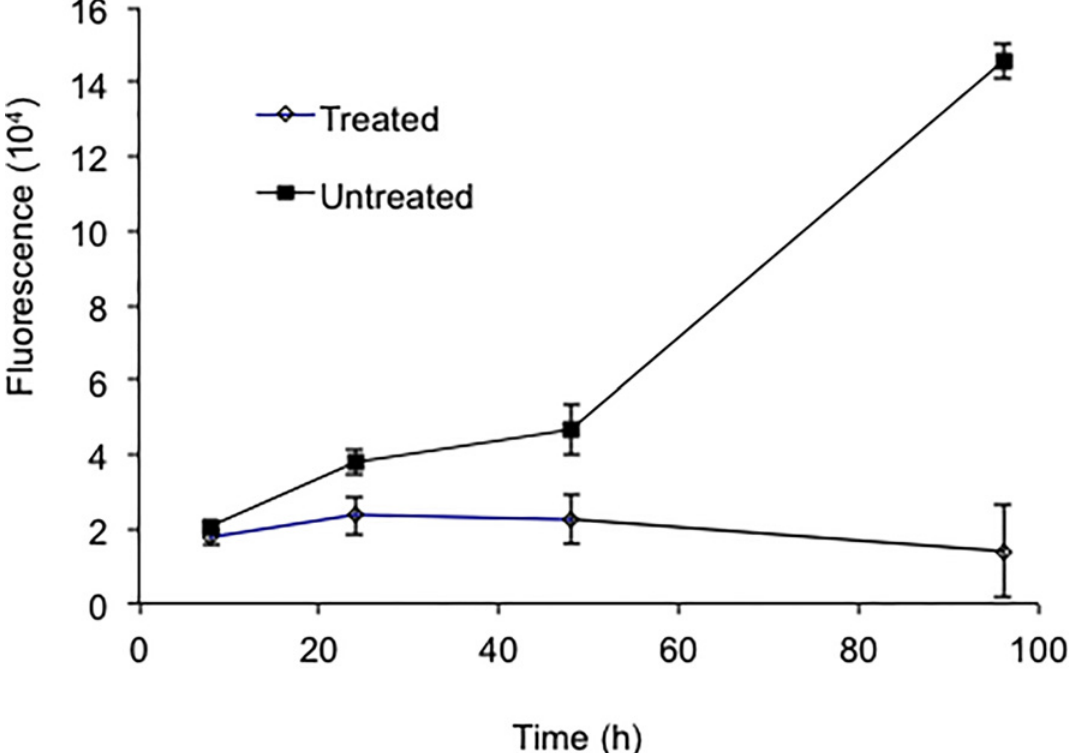
Fig 6. In vitro evaluation of anti-TB therapeutic efficacy using the M . bovis BCG L5-tdTomato strain. Fluorescence of treated or untreated M . bovis BCG L5-tdTomato strain was measured with a multimode reader. The initial CFU for the treated or untreated was 10 6 . The treated group was given 64 ng/ μ l rifampicin and isoniazid. At each time point, bacteria were loaded into a 96-well plates as quadruplicate samples for each group. The Y-axes represent mean fluorescence for the quadruplicates. Data represents one of two independent replicate experiments. Error bars are standard deviations. Repeated Measures Two-way ANOVA was performed to examine overall difference between the two groups (treated vs. untreated) through multiple time points. Comparison of treated with untreated group was matched at each time point. P <